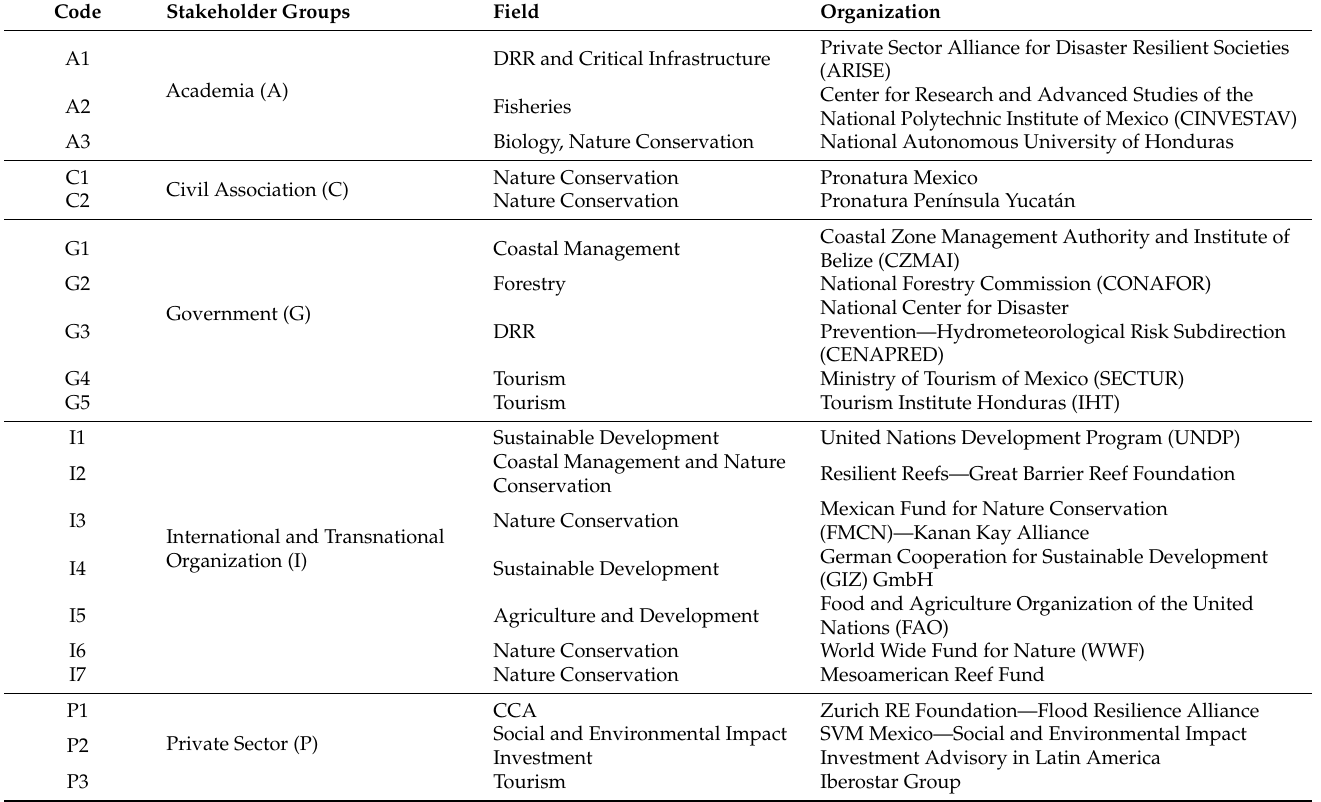
Table 2. List of stakeholders interviewed. Source: Authors